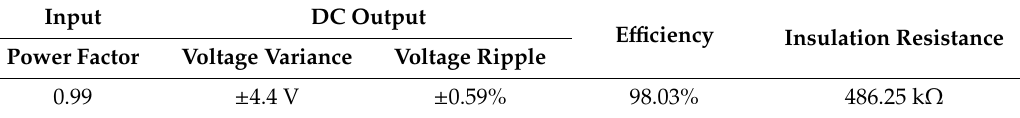
Table 6. Voltage quality results from the AC / DC power converter demonstration